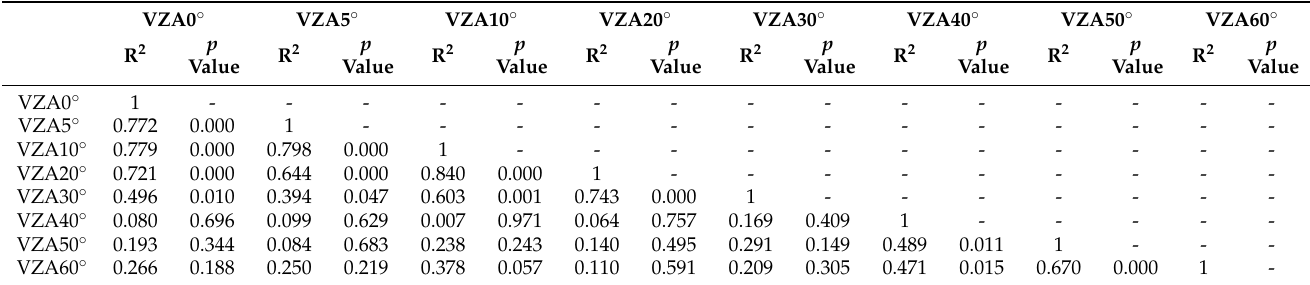
Table 2. Coefficient of determination (R 2 ) between the TCARI values at different view zenith angles (VZAs).